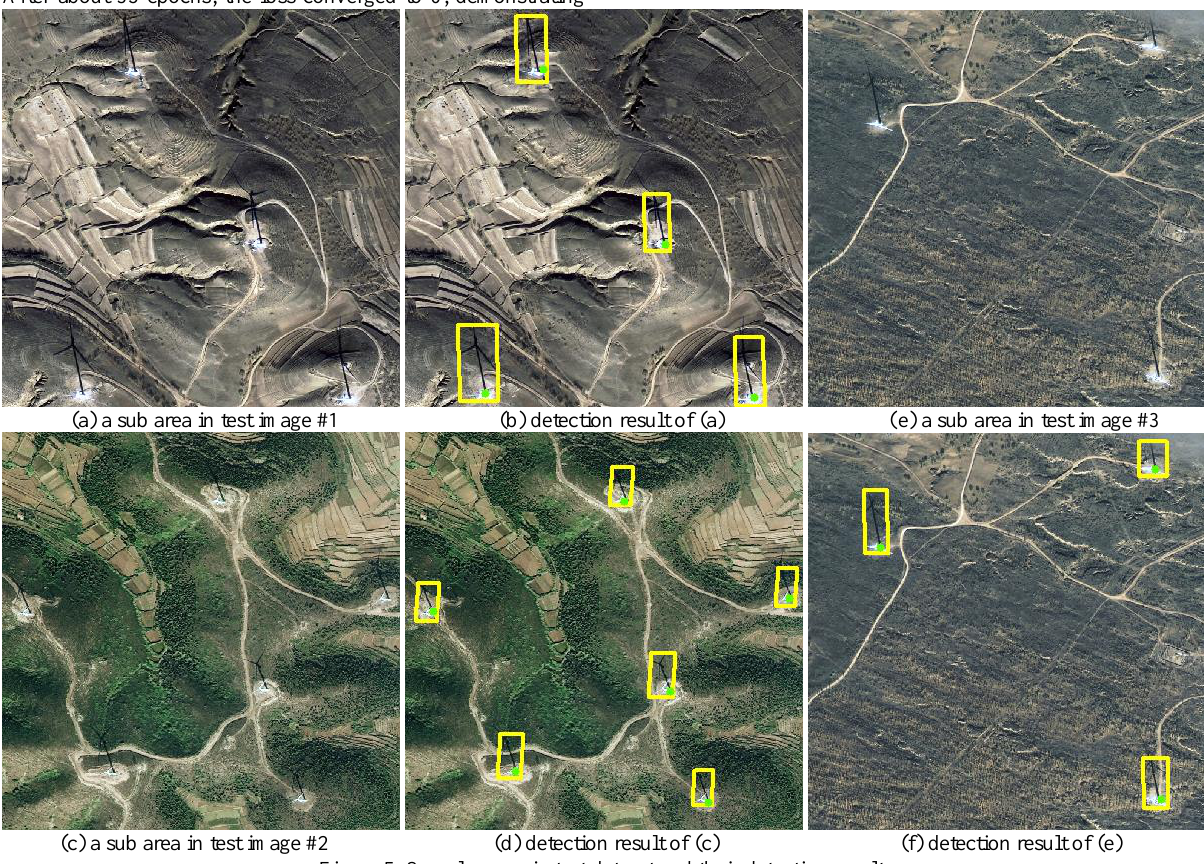
Table 1. Parameters in training step In this experiment, we choose two images for training and others for test. Parameters in training step can be found in Table 1.